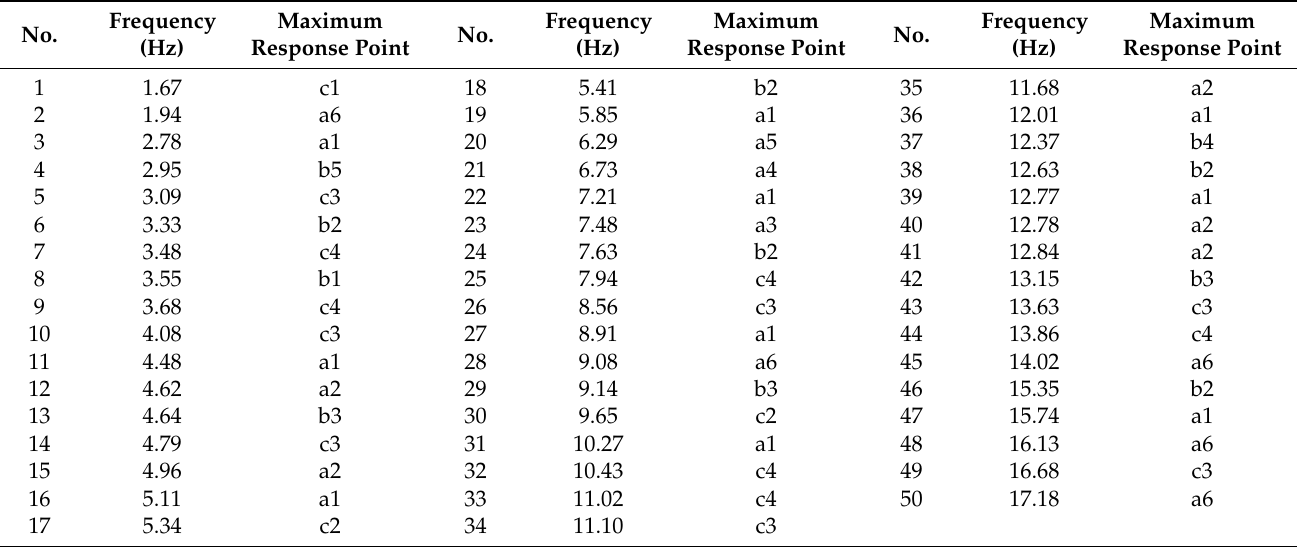
Table 3. Relationship between frequency and shape variables under free mode of Camellia oleifera model.